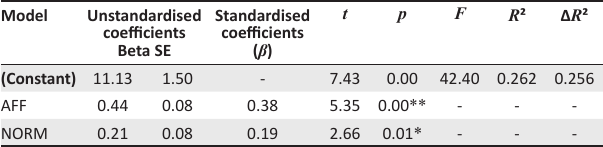
TABLE 4: Multiple regression with dedication (work engagement) being the dependent variable and normative and affective commitments (organisational commitment) the dependent variables.